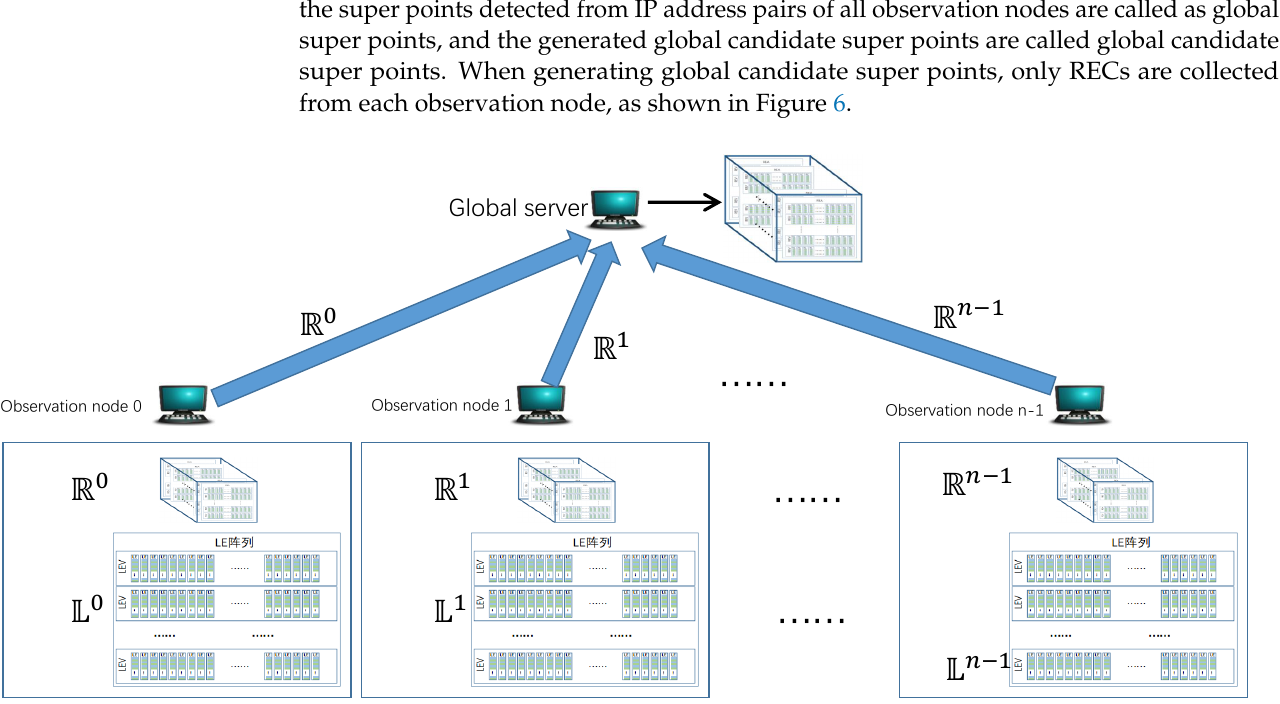
Figure 6. Collect REC from observation